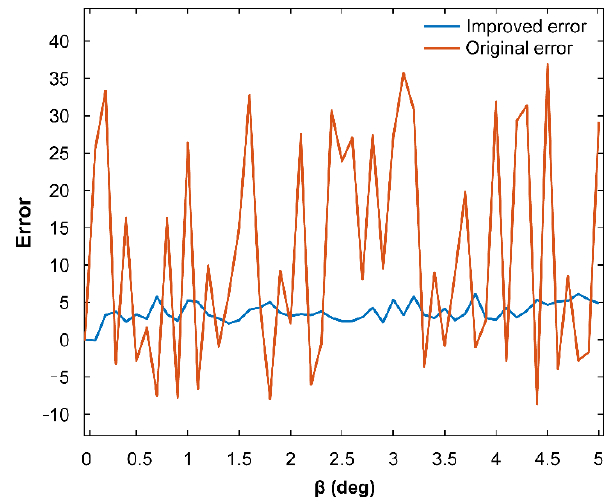
Figure 11. Schematic diagram of the experimental process.